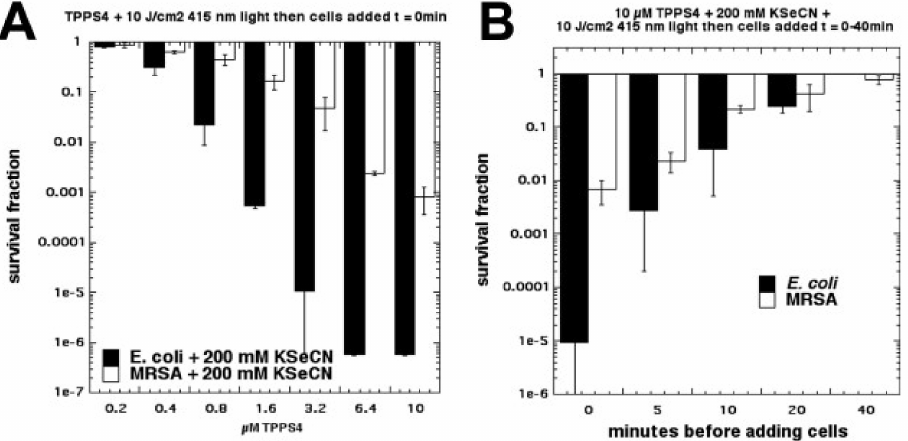
Figure 14. aPDI mediated by TPPS4 + potassium selenocyanate in “after” format. ( A ) Killing of MRSA and E. coli as a function of TPPS4 concentration; ( B ) Time-dependent decay of antibacterial activity of TPPS4 + KSeCN + light. Figure adapted from data contained in